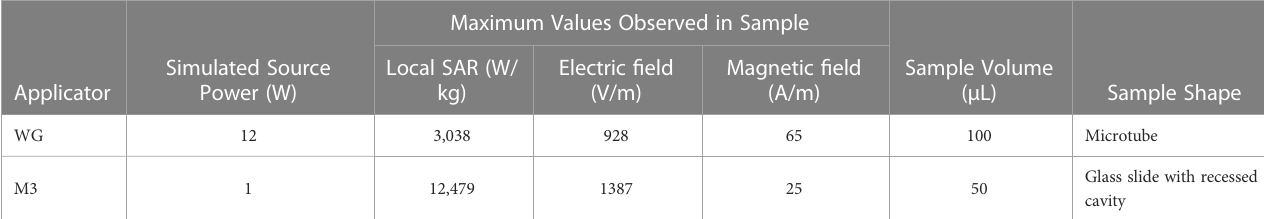
TABLE 1 Measures obtained in